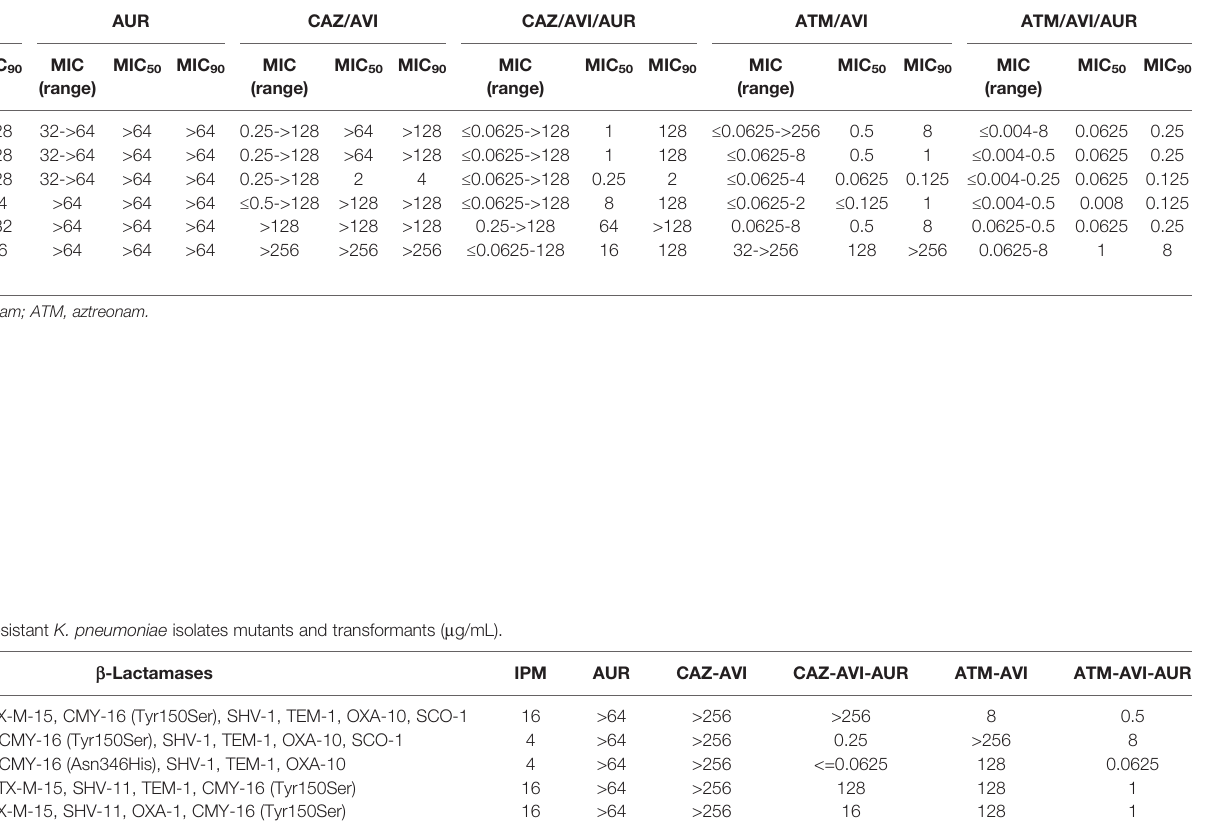
TABLE 1 | MICs of CAZ-AVI-AUR and ATM-AVI-AUR against CPE isolates ( m g/mL). Strains (n)